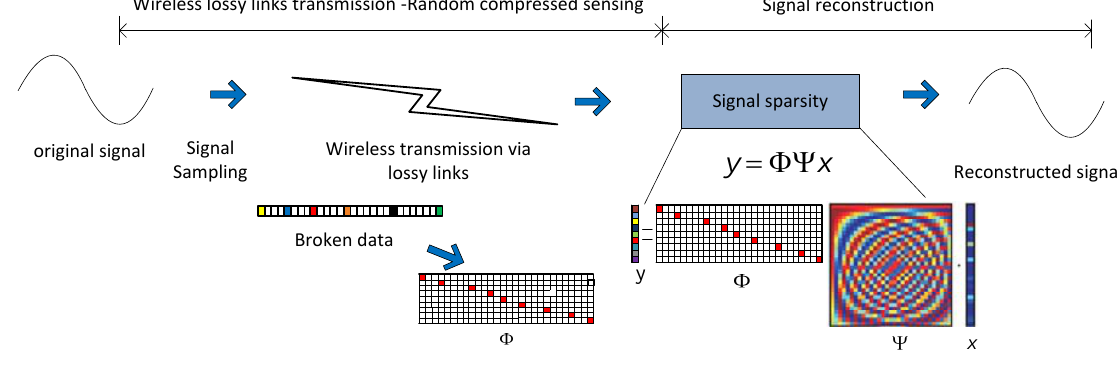
Figure 3. Process of reliable information